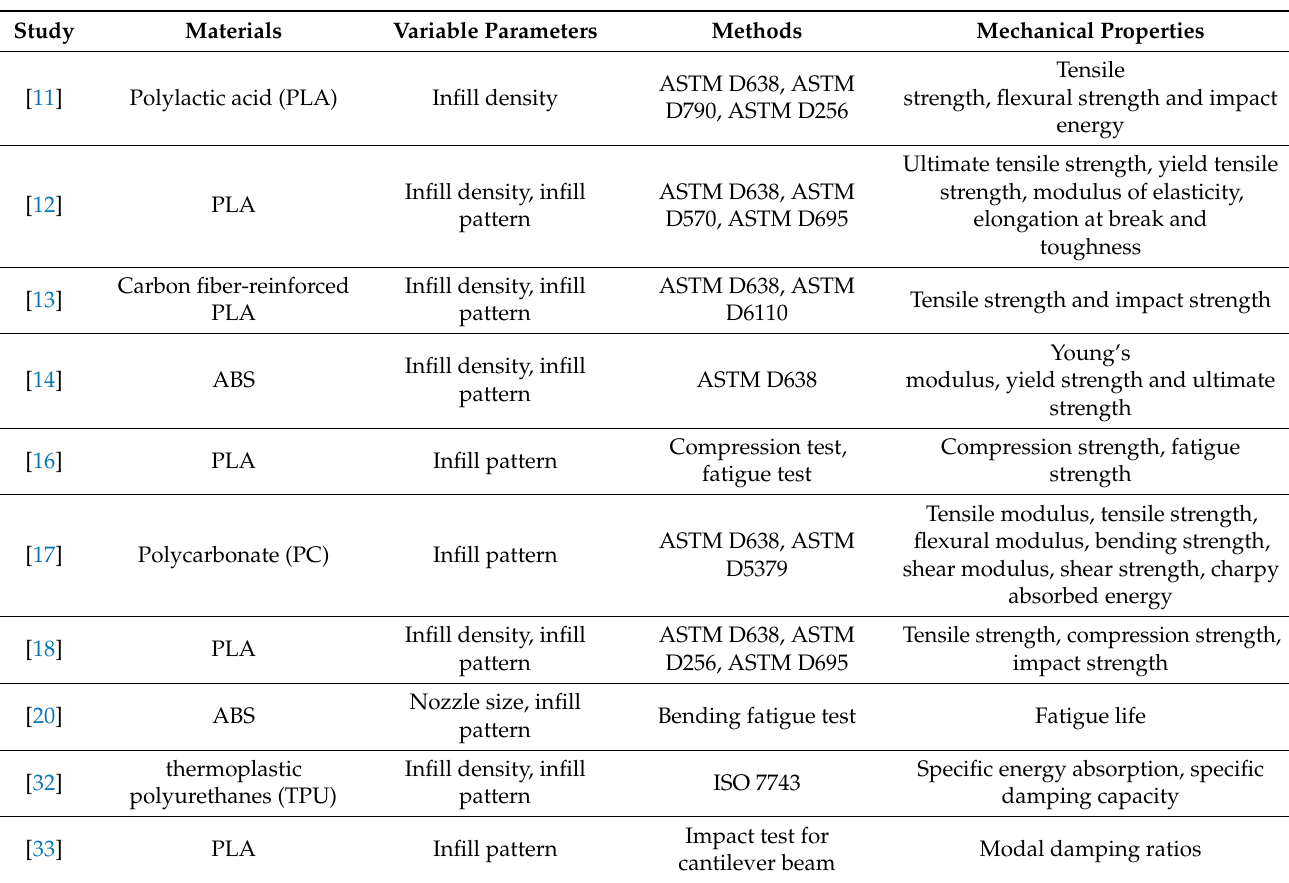
Table 9. Some previous studies investigating the influence of the same process parameters influence on mechanical